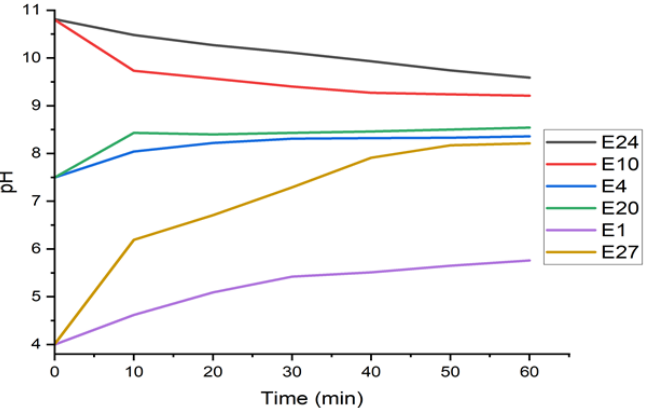
Figure 4. Variation of the pH in the time of treatment by electrocoagulation/O 3 .